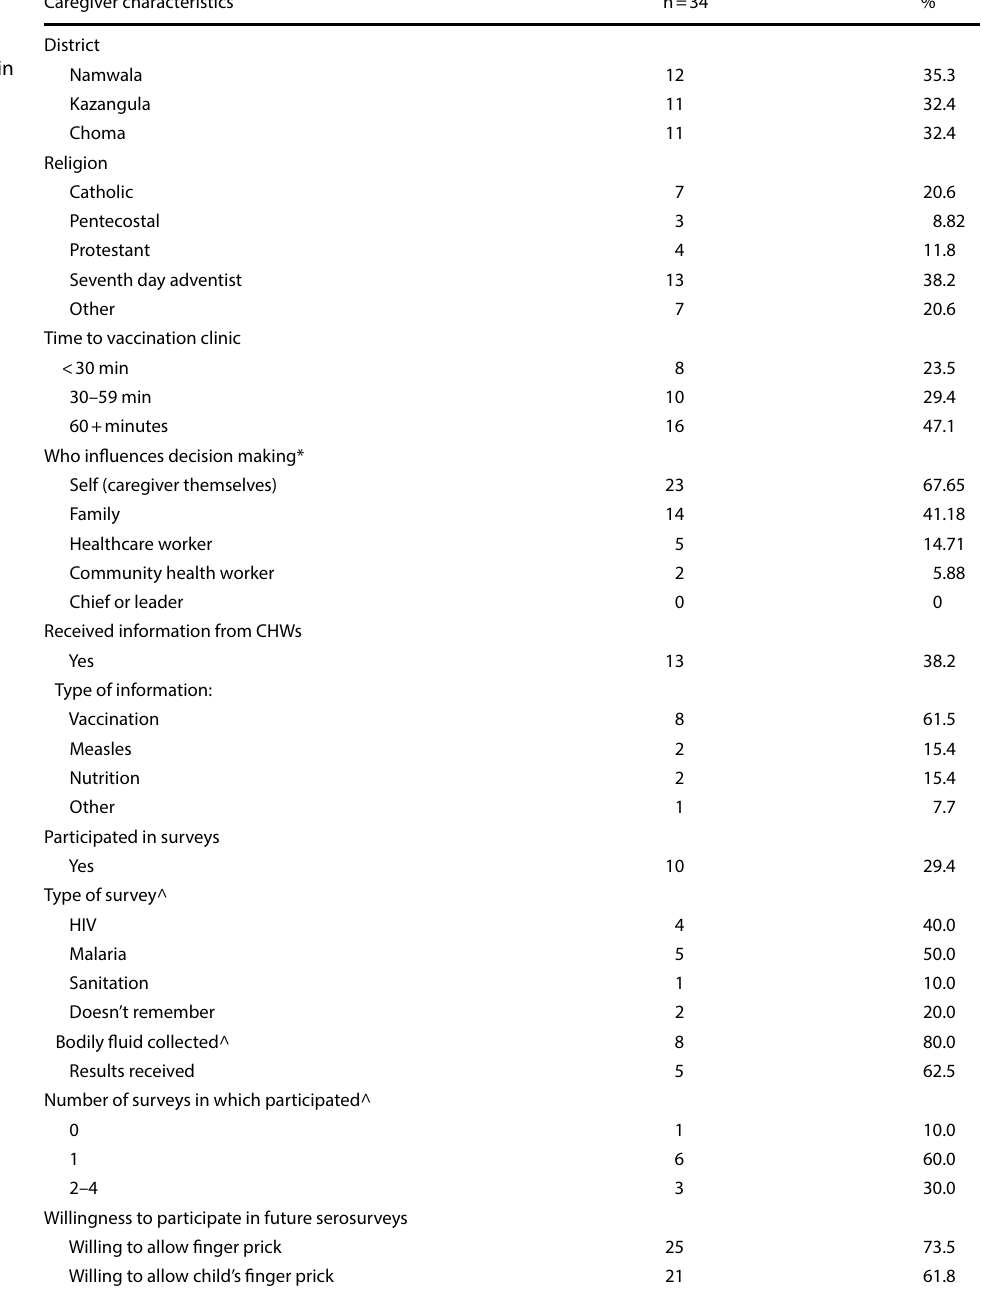
Table 2 Socio-demographic factors and serosurvey response characteristics of caregivers who participated in the